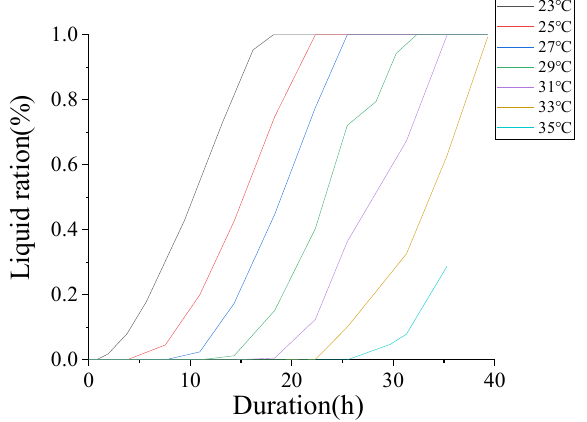
Figure 9. Effect of phase change temperature on melting rate of the heat storage module.